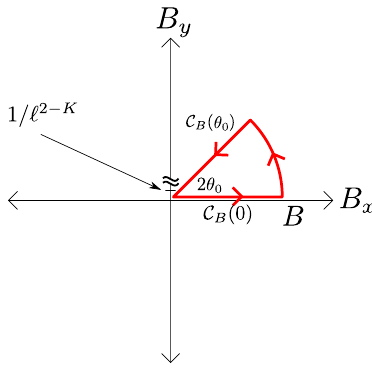
Figure 4: The “slice-of-pie” countour in the B for the two Majorana modes at a given corner. The magnetic field in the semicircle portion is in the tight-binding regime Ba (cid:29) ( a /(cid:96) ) 2 − K .